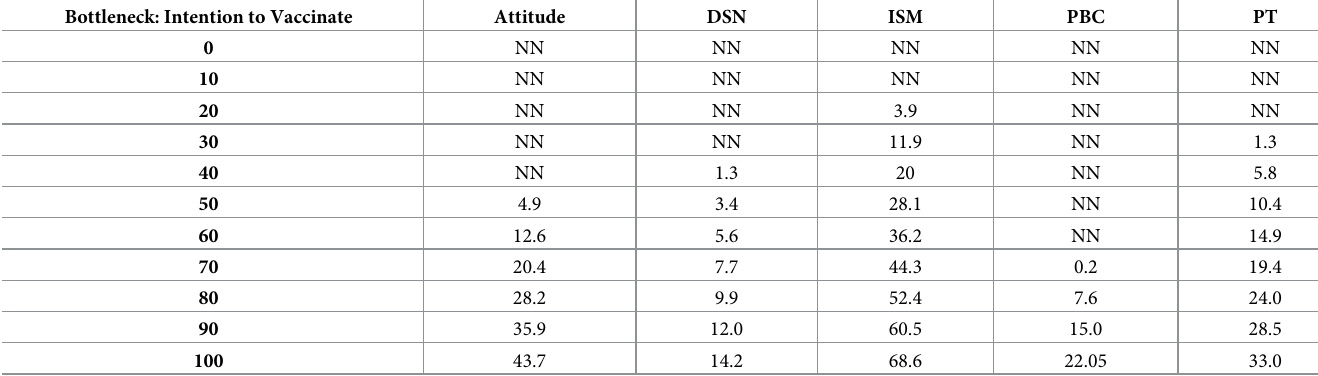
Table 8. Bottleneck analysis with ceiling envelopment–free disposal hull.